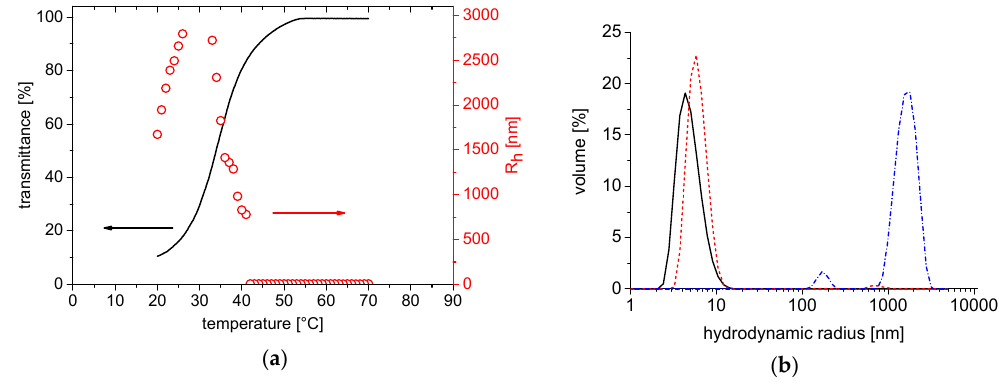
Figure 8. Temperature dependent study of 3.0 g·L − 1 solutions of statistical block copolymer PEG- b -P(SPE- co -ZPE)-2 in NSS: ( a ) by turbidimetry (cooling run); values for the apparent average hydrodynamic radius R h are also shown. ( O ); ( b ) distributions of the hydrodynamic radii at 20 °C ( -·-·-·- ), 41 °C ( - - - - - ), and 70 °C ( — ).